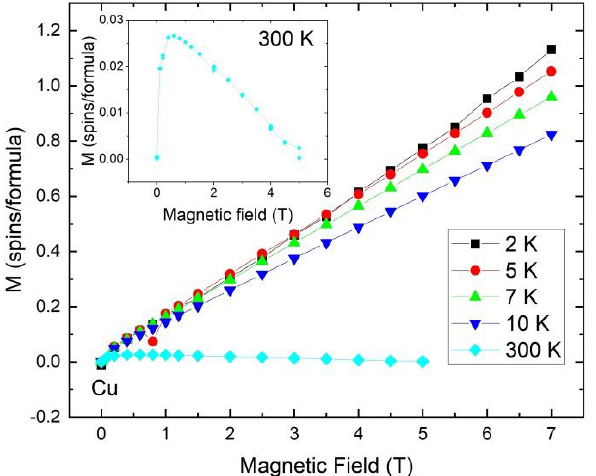
Figure 11. Magnetization of Cu(L)Cl 2 as the function of magnetic field at 2.0, 5.0, 7.0, 10.0, and 300.0 K. The data show raw measurements after the extraction of an off-center linear diamagnetic background M / B ≈ − 0.044 µ B / formula T − 1 , associated with the sample holder. The inset shows a magnification of the data at 300 K.